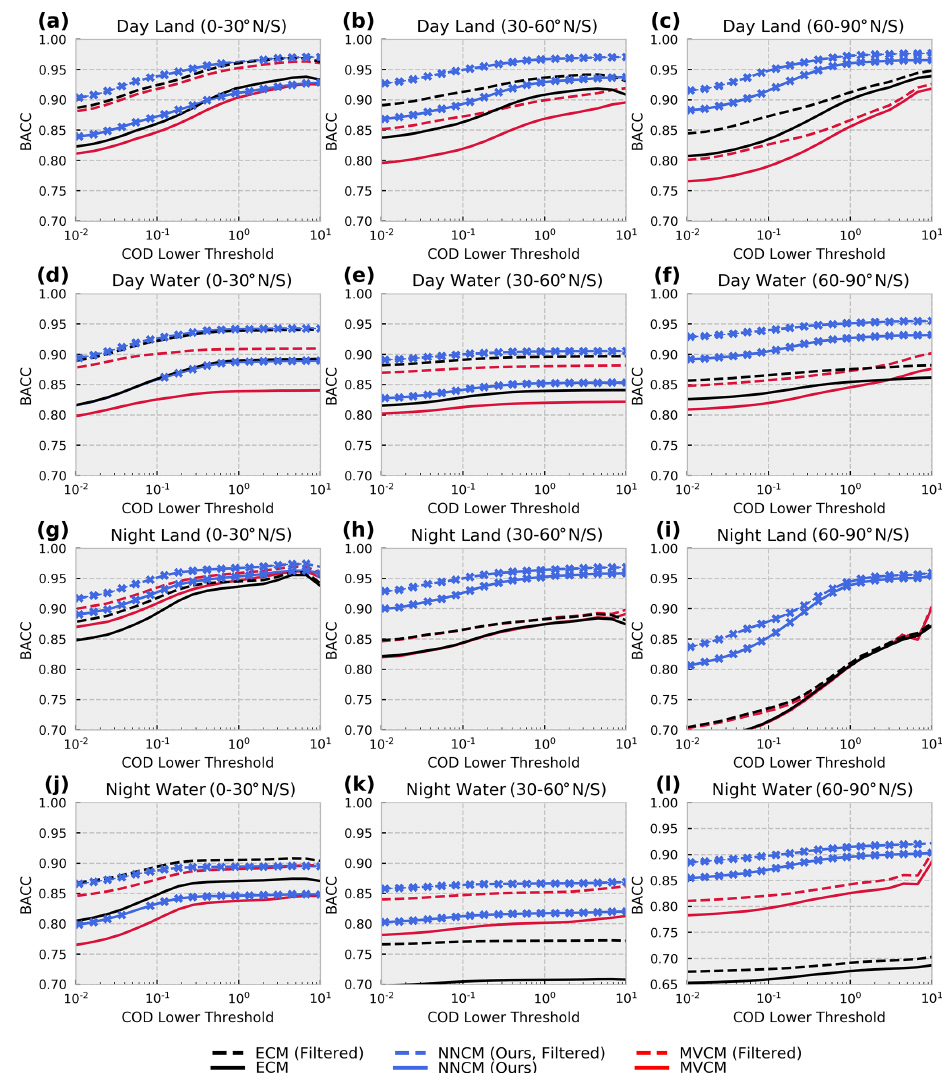
Figure 9. Balanced accuracy (BACC) recalculated after removing clouds below a certain cloud optical depth (COD) threshold. Tick marks on the neural network lines indicate significant differences in performance between the neural network and the best operational model using McNemar’s test with p values less than 0.001. Note that the y -axis limits are different for (l) compared to the other